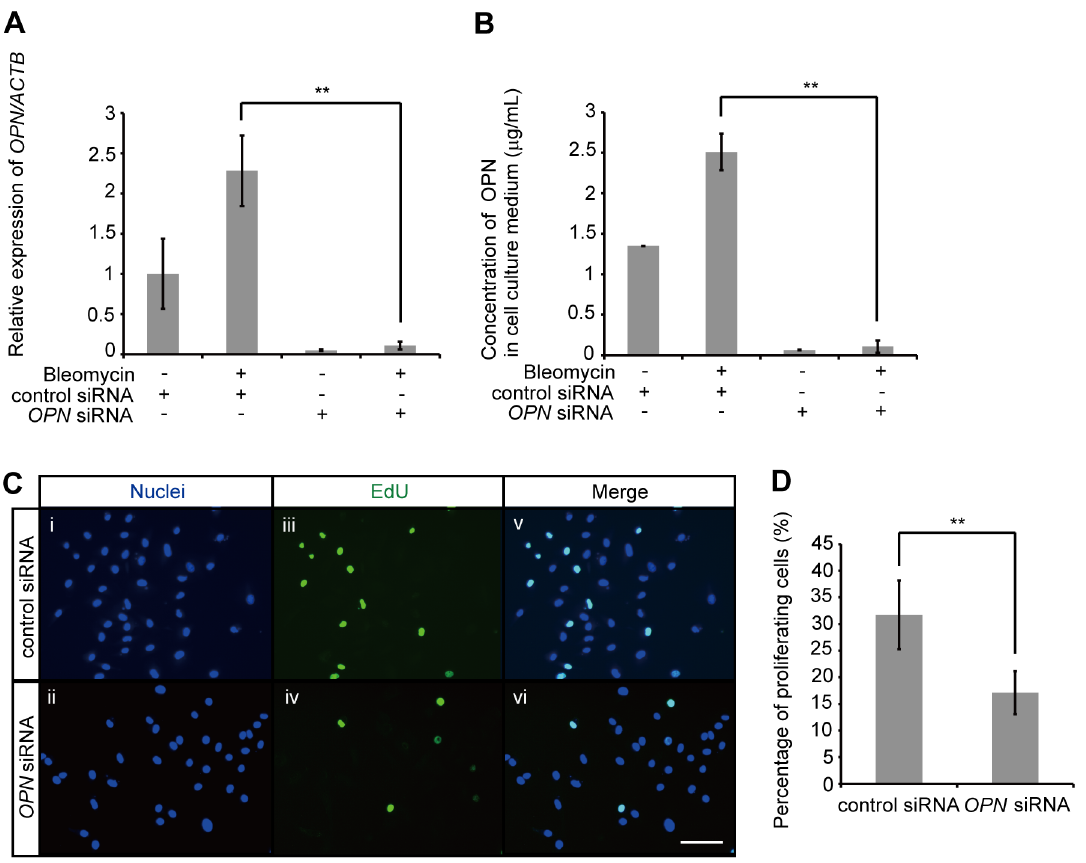
Figure 6. Effect of OPN on the proliferation of A549. (A and B) A549 were transfected with 20 nM human OPN siRNA or control siRNA. Twenty- four h after transfection, A549 were incubated for 48 h in the presence of 1 m g/mL bleomycin or PBS. (A) OPN mRNA was assessed by qRT-PCR. (B) OPN concentrations in cell culture media were determined by ELISA. (C and D) A549 were transfected with 20 nM human OPN siRNA or control siRNA. Twenty-four h after transfection, A549 were exposed to 1 m g/mL bleomycin for 48 h and then incubated with EdU for an additional 15 h. A549 were stained with Alexa Fluor 488 azide and HCS NuclearMask Blue stain. The cells were visualized by pseudocoloring with the Floid Cell Imaging Station. (C) Nuclei (i, ii) show representative photomicrographs of all cells. EdU (iii, iv) show representative photomicrographs of proliferating cells. Merge (v, vi) show representative photomicrographs of merged images. Bar: 100 m m. (D) Twelve fields per well were recorded and the number of positively-staining cells was counted. The percentages of proliferating A549 that were transfected with either human OPN siRNA or control siRNA are shown. Data are presented as mean 6 S.E. *, P , 0.05; **, P , 0.01.